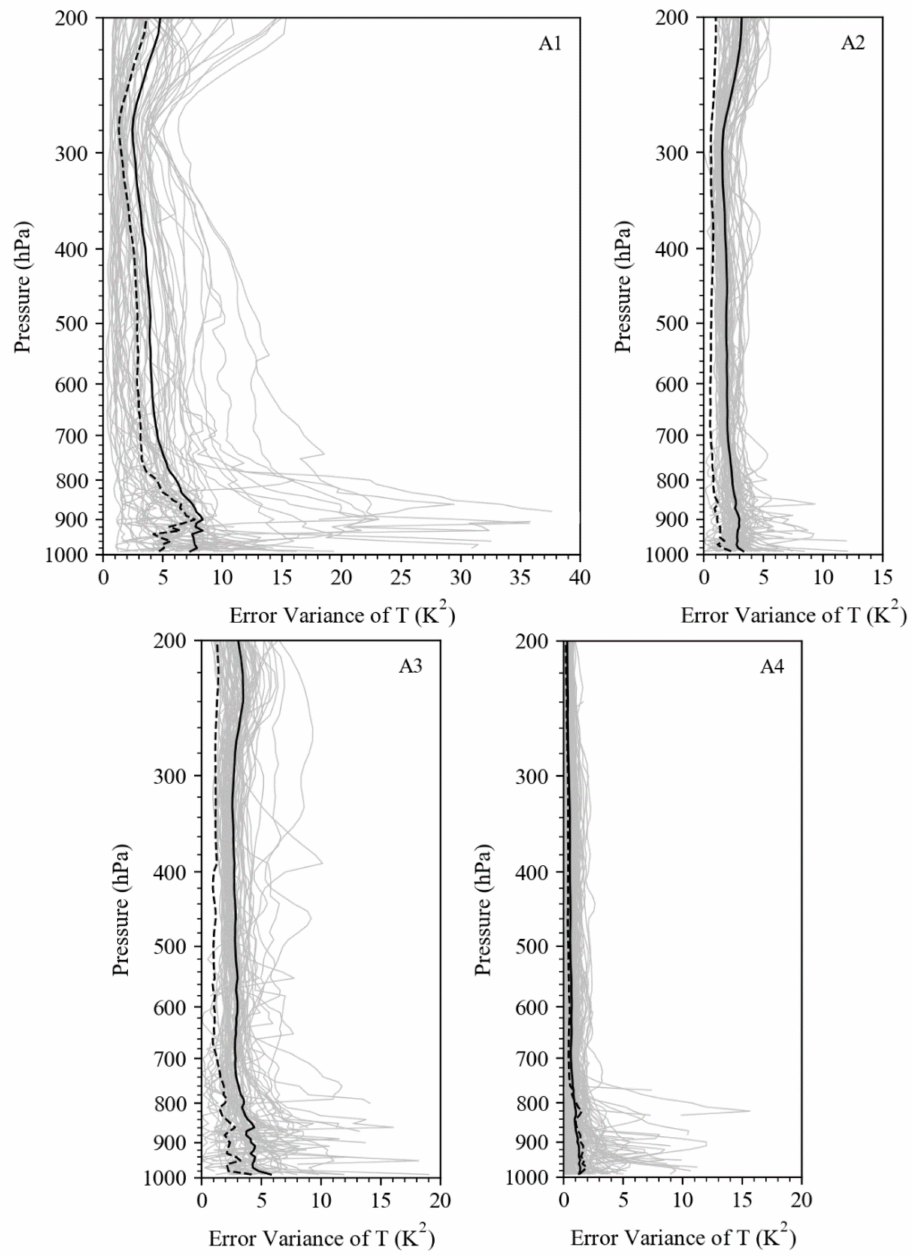
Figure 9. Vertical profiles of RS temperature error variance at the RS stations located in the four areas (A1 to A4) framed in Figure 9a, along with their means (solid curves) and standard deviations (dashed